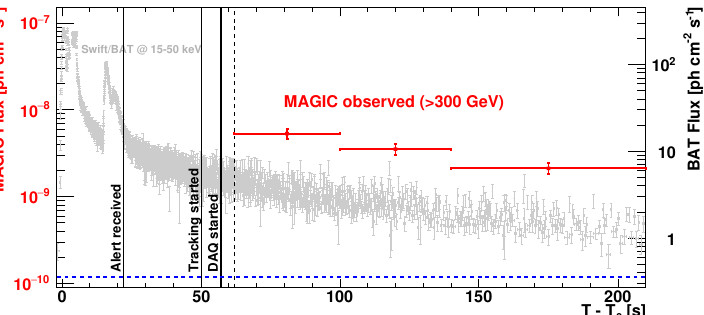
Figure 7. Light curves for MAGIC and Swift -BAT. Vertical solid lines show the times of events related to the MAGIC automatic procedure. Extracted from Ref. [2].